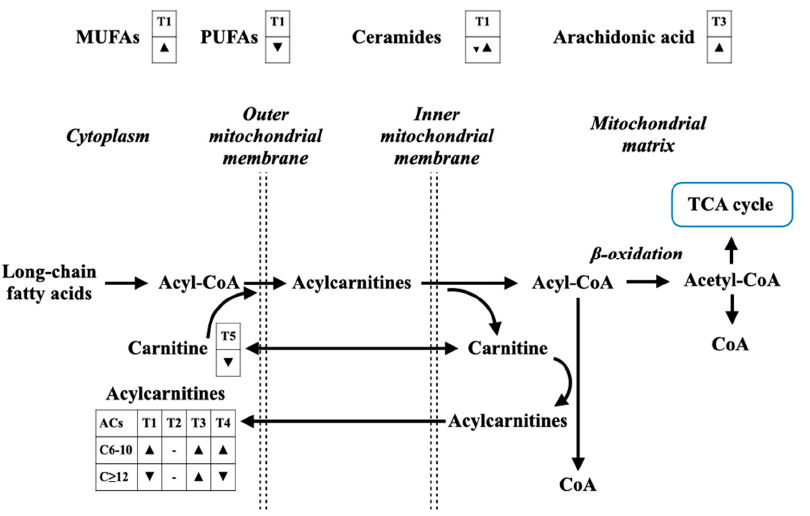
Figure 2. The alterations of fatty acids and fatty acid-related metabolites for sepsis diagnosis (Table 1), septic shock diagnosis (Table 2), prognostication of sepsis (Table 3), prognostication of septic shock (Table 4), and monitoring the treatment response (Table 5). A down-sided triangle ( (cid:72) ) represents a decreased level, whereas an up-sided triangle ( (cid:78) ) represents vice versa. Monounsaturated fatty acids (MUFAs) are found increased in sepsis diagnosis, whereas polyunsaturated fatty acids (PUFAs) are found contractedly. Most of ceramides are increased, together with an increase in arachidonic acids. Long-chain fatty acids enter mitochondrial for fatty acid oxidation ( β -oxidation) under the carnitine shuttle process. The final product of β -oxidation is acetyl-CoA that can enter TCA cycle for an energy production. However, mitochondrial dysfunction in sepsis can alter β -oxidation process, leading to an accumulation of medium-chain acylcarnitines in the cytoplasm and in the circulation, which indicates incomplete β